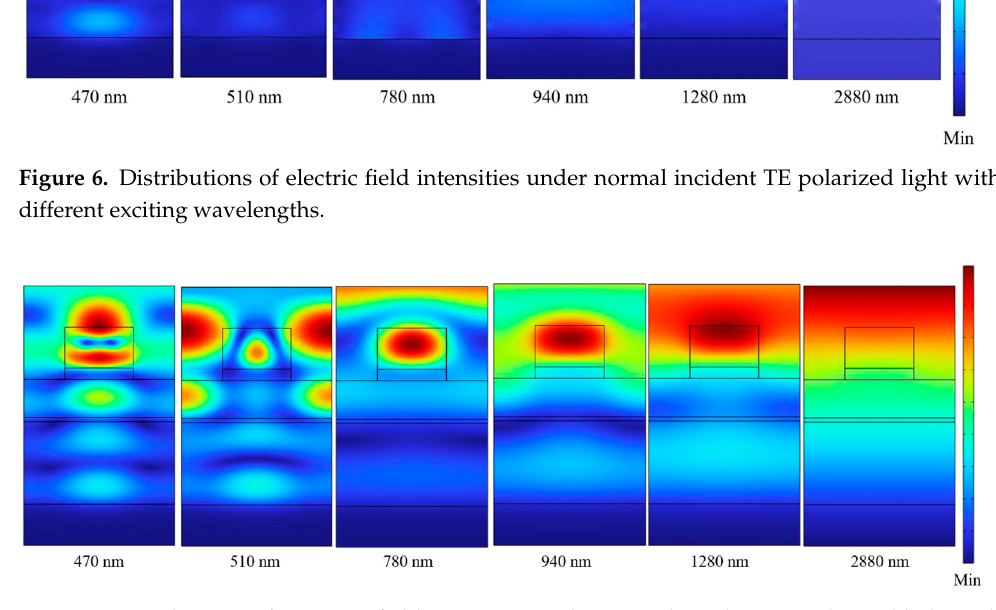
Figure 8. Evolution absorptivity of TE-polarized light with normal direction and different oblique incidence angles. The effect of different polarization angles on the absorption performances of the de- signed absorber with normal incident light is shown in Figure 9. A polarization angle of 0° indicates that the polarization direction of the incident light is along in the x direction (or called as TE polarization), and a polarization angle of 90° indicates that the polariza- tion direction of incident light is along in the Y direction (or called as TM polarization). In Figure 9, the distributions for evolution absorptivity show that the absorptivity is almost